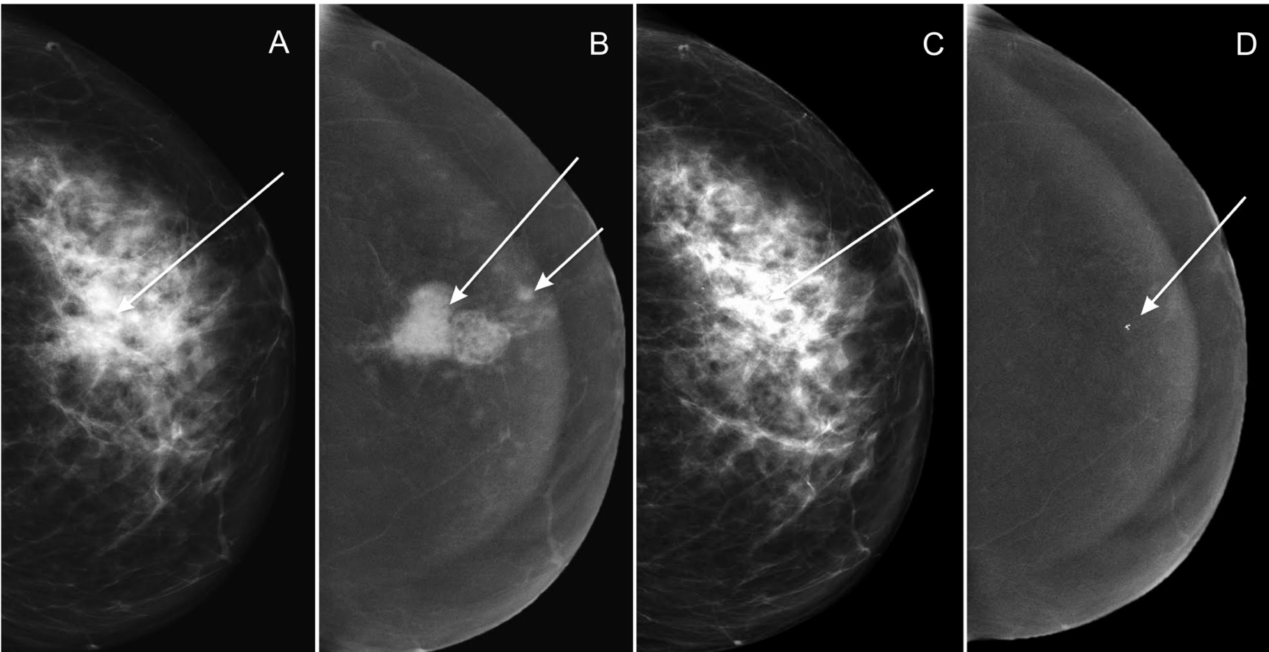
Figure 5. Assessment of therapeutic response in low-energy CESM CC images ( A , C ) and subtraction CESM CC images ( B , D ) before NAC (IDC LumB, G2 T3N1)showing irregular infiltration on the border of the outer quadrants of the left breast with high density ( A ), revealing pathological contrast enhancement on subtraction CESM images ( B ). Additionally, satellite foci are visible in subtraction CESM images, which were confirmed in core-needle biopsy (smaller arrow) ( B ). Following NAC, there was a visible focal asymmetry, with a density slightly lower than the infiltration before NAC ( C ), shown again without pathological contrast enhancement ( D ). Based on the low-energy CESM images, the therapeutic response was classified as stable disease (SD). Based on the subtraction CESM images, the therapeutic response was classified as complete response (CR), which was acknowledged in the HP